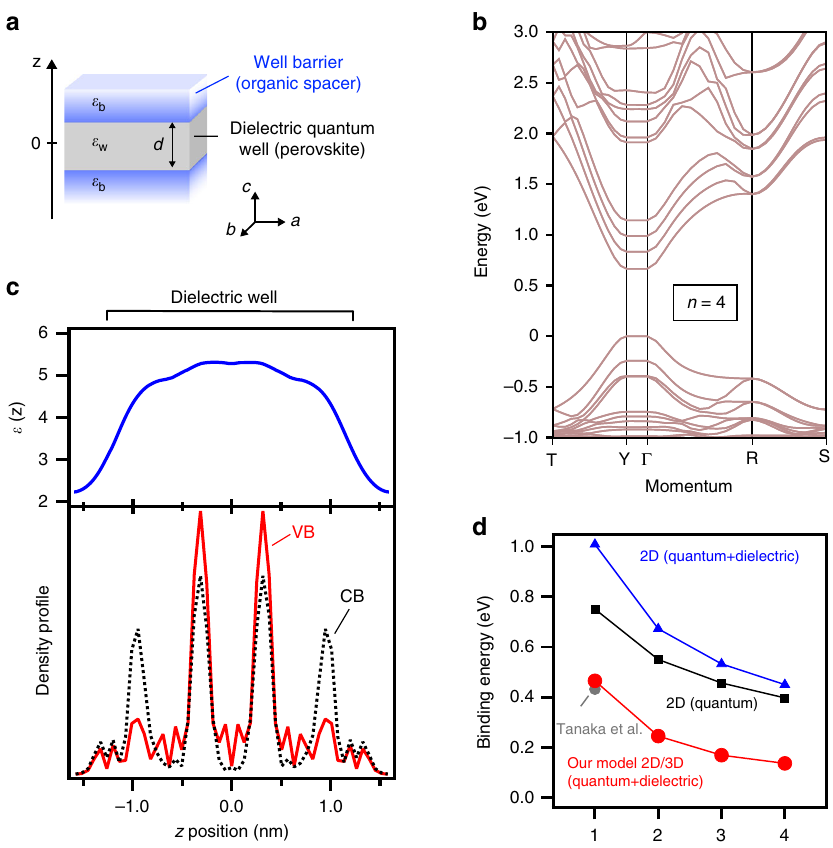
Fig. 2 Semi-empirical model of Wannier – Mott exciton in RPPs. a Schematics of the single quantum well system to which our model was applied to. b Computed band structure for the RPP with n equals to 4. c Corresponding electron (dashed black lines) and hole (red) probability density pro fi les, and high-frequency dielectric constant pro fi le (blue) along the stacking axis ĉ . d Calculated binding energy of the exciton ground state using the exciton reduced mass in Fig. 1f and the DFT results. The values calculated using our model results (red circles) is compared to those obtained in the approximation of a pure 2D system (blue triangles) and of a pure 2D system without dielectric con fi nement (black squares). The binding energy of the excited exciton states (2 s , 3 s , 4 s ) were also computed and are reported in Supplementary Fig. 7. For reference, the 3D perovskite MAPbI 3 yields an exciton binding energy of about 16 meV, from Miyata et al. 16 and in agreement with our results in Supplementary Fig.